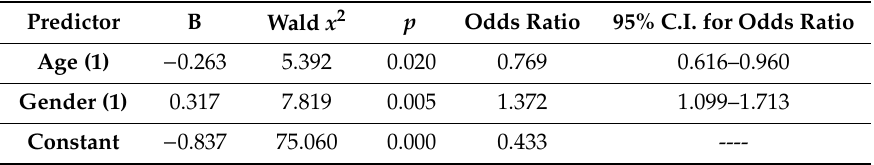
Table 5. Logistic regression